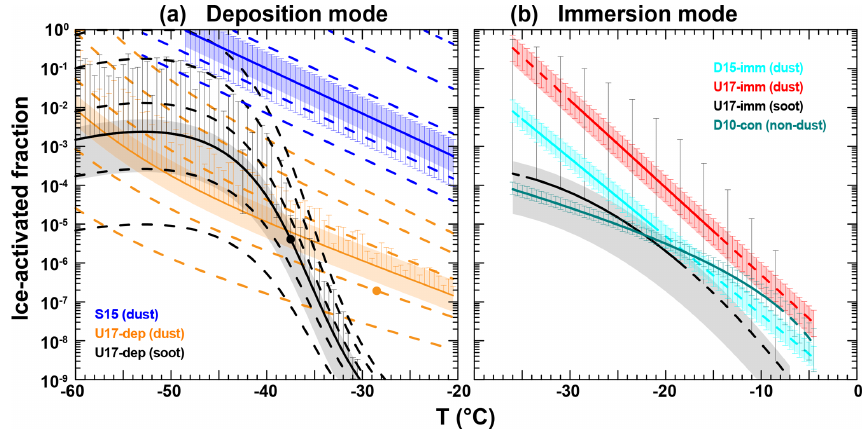
Figure 1. Fraction of ice-activated particles for the deposition nucleation (a) and immersion freezing (b) parameterizations used in this study. The particle concentrations used are derived assuming an extinction coefficient of 50Mm − 1 for each of the different aerosol types (dust, continental, soot). The shaded areas take into account a range of the extinction coefficient from 10Mm − 1 (lower limit) to 200Mm − 1 (upper limit). The error bars mark the error of the respective parameterizations from error propagation using the uncertainties provided in Table 2. Negative error bars that exceed the scale are not shown. In the deposition mode (a) , the bold lines correspond to ice supersaturation of 1.15 and the dashed lines to ice supersaturation of 1.05, 1.1, 1.2, 1.3 and 1.4. The black and orange dots indicate the maximum temperatures for which the parameterizations have been developed. In the immersion mode (b) , the parameterizations are extrapolated over the immersion freezing temperature range (dashed